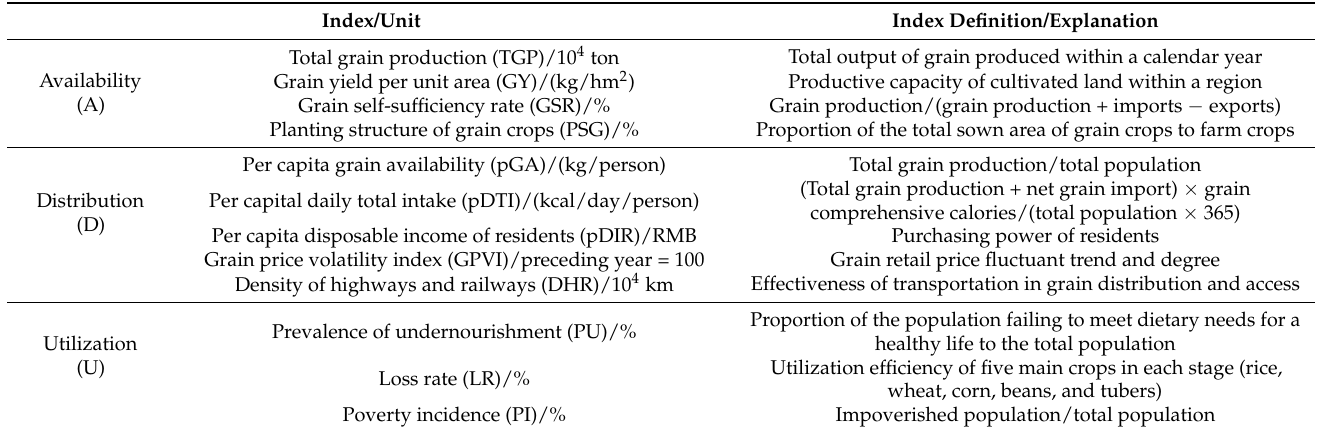
Table 1. Evaluation index system of China’s food